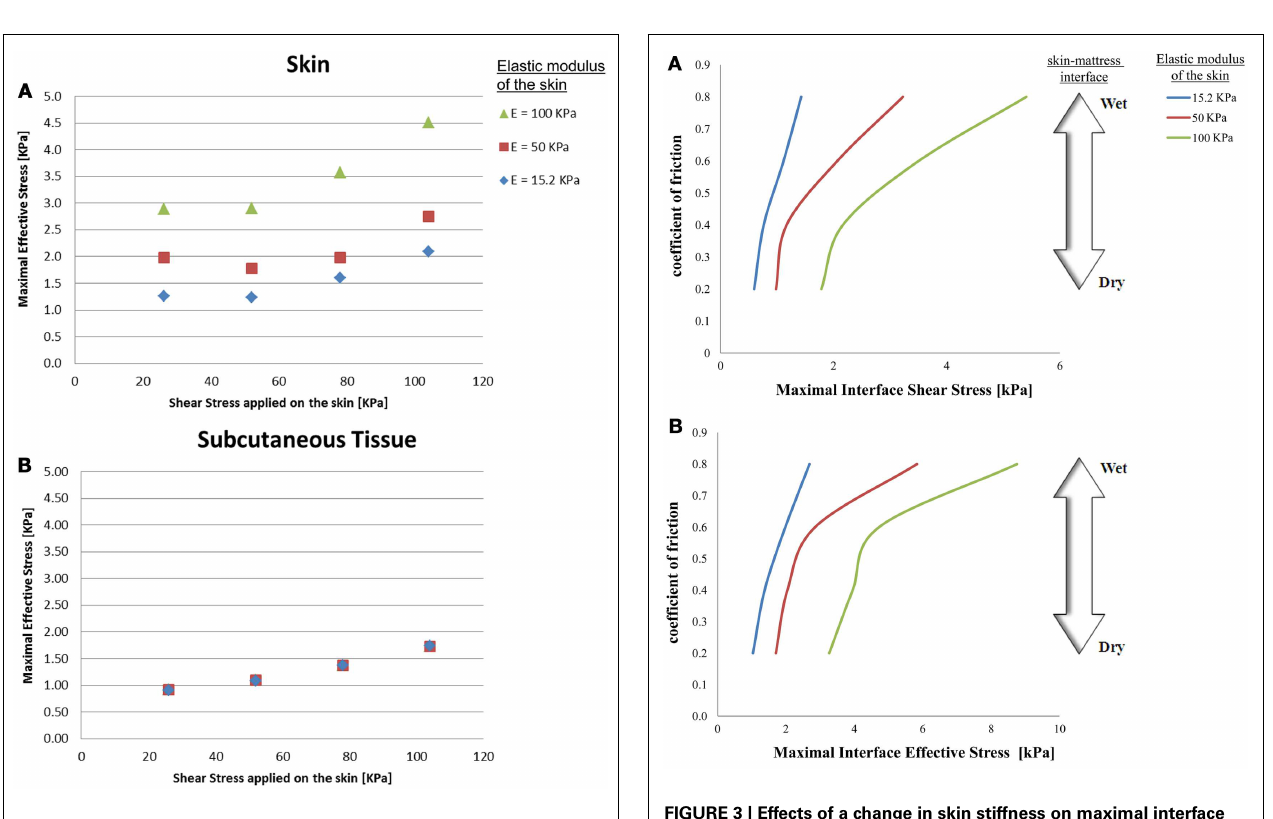
FIGURE 2 | Effects of a change in skin stiffness on the inner maximal effective stress: (A) skin stresses and (B) subcutaneous tissue stresses . The stress analysis was time-dependent and the values referred to are the maximal stresses that occurred at the end of the maneuver of the simulated dragging of the body part over the mattress.